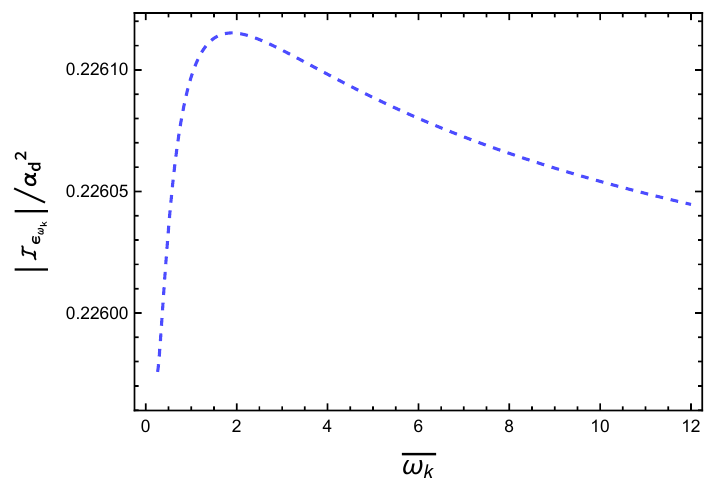
is plotted for two outgoing null detectors in a (1+1) dimensional Figure 10 . The quantity |I ε | /α 2 d ωk de Sitter spacetime with respect to the dimensionless frequency of the field ω and d/α = 0 . d